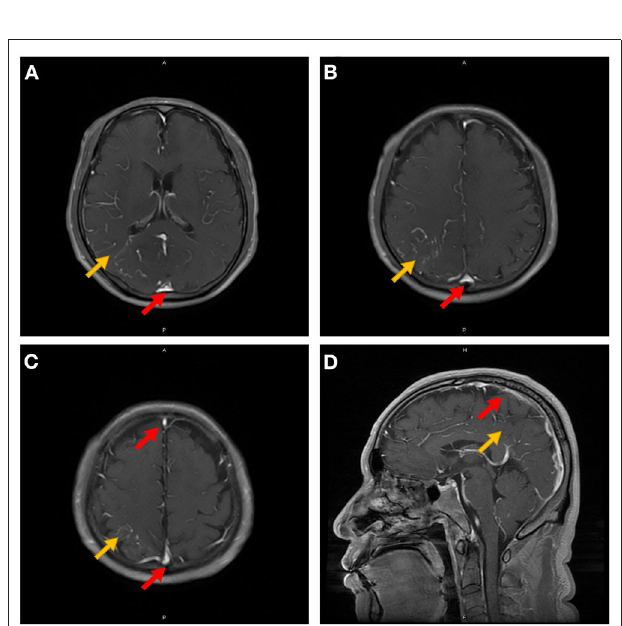
FIGURE 2 | Contrast-enhanced MRI of the brain in Case 5. The orange arrow indicates leptomeningeal or medullary vascular enhancement in the right parietal-occipital lobe, and the red arrow indicates the simultaneous venous sinus enhancement (A–D)